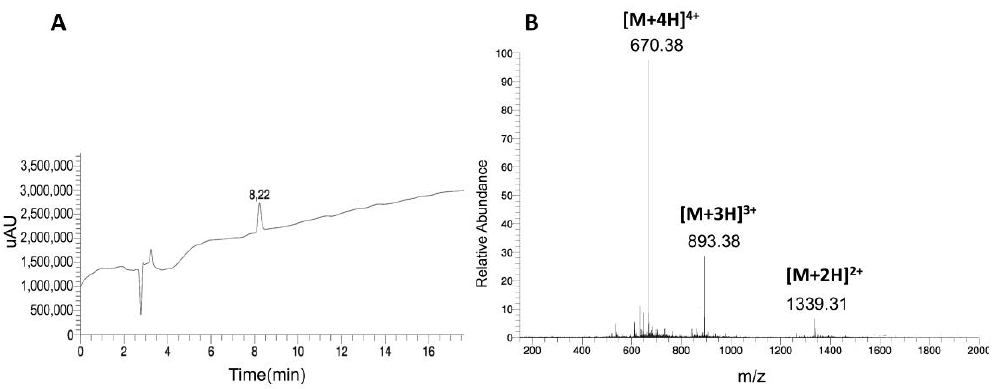
Figure 2. Analytical data of 5-FDR-C-CPE-17-KKK ( 1 ): ( A ) HPLC chromatogram obtained with a gradient of 10% to 60% acetonitrile-water over 20 min. ( B ) ESI-MS spectrum of the compound (see experimental section for more details).